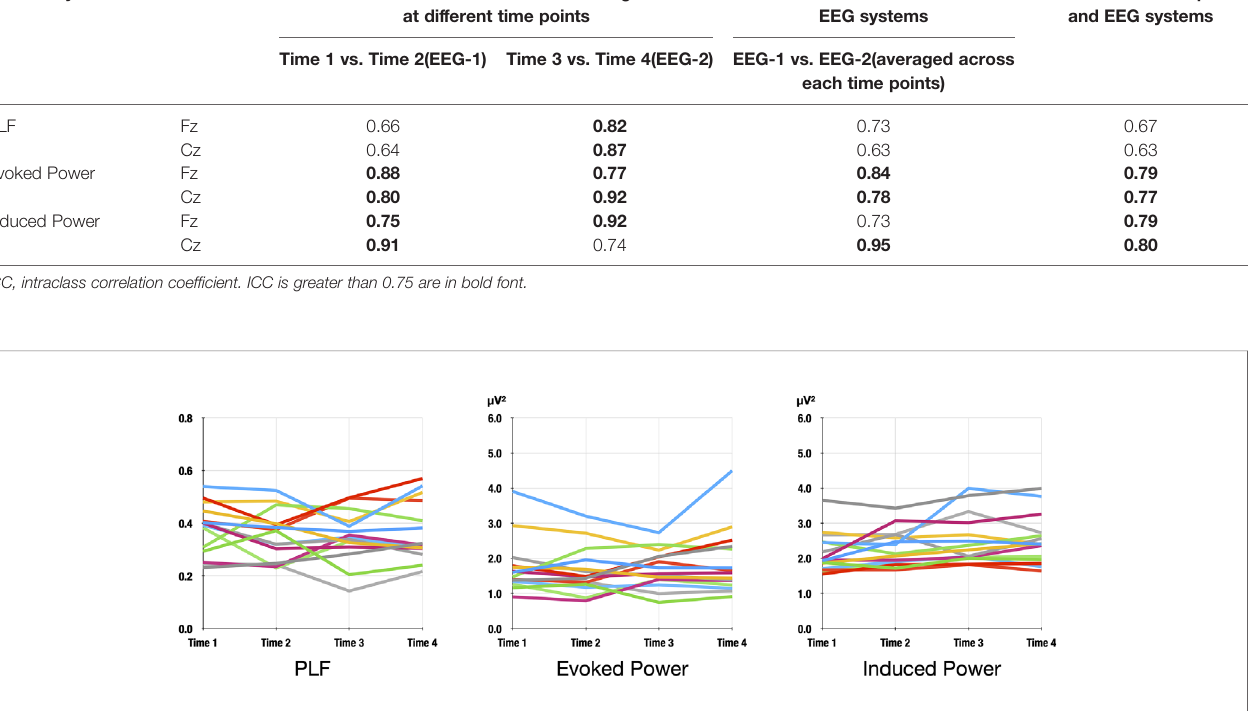
TABLE 1 | Summary of the test-retest reliability indexed by intraclass correlation coef fi cient. Oscillatory measures Electrode ICC between each EEG recordings